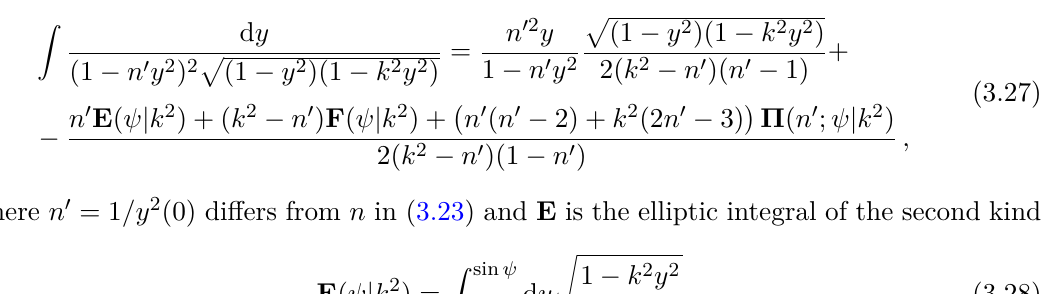
= 0 . 262 , J = 0 . 210 ϕ ϑ −